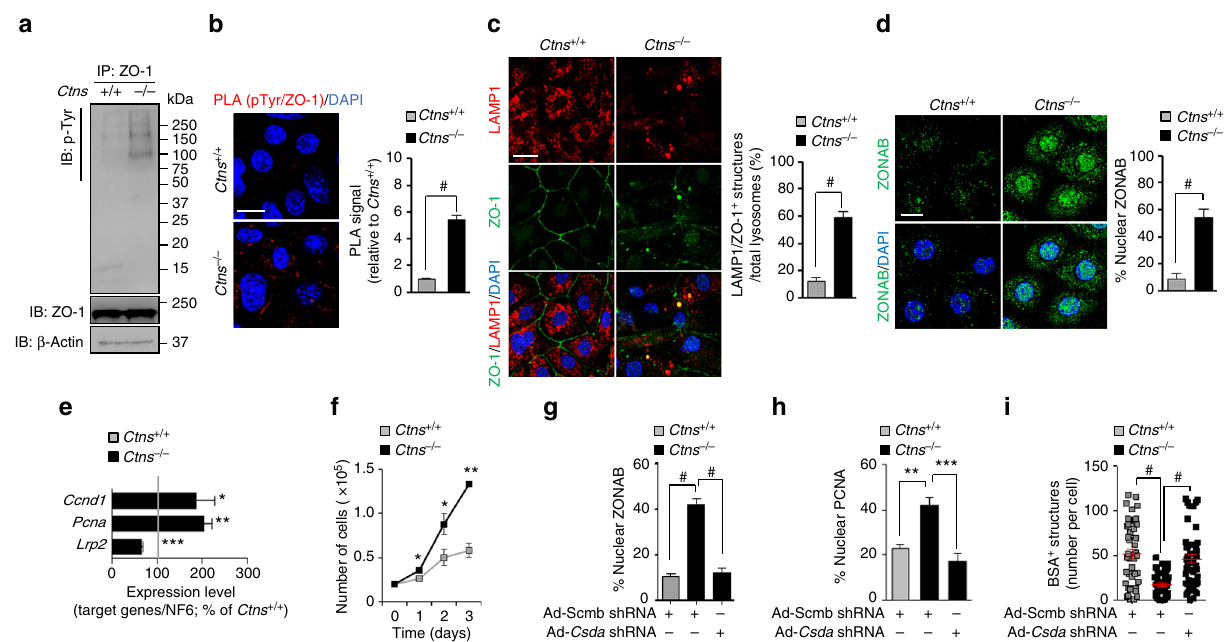
Fig. 7 Augmented phosphorylation rate of ZO-1 promotes epithelial dysfunction in Ctns − / − cells. a Tight junction ZO-1 protein was immunoprecipitated from Ctns + / + and Ctns − / − mPTCs, and its phosphorylation rate was examined by western blotting, n = 2 independent experiments. b Confocal analysis of endogenous phosphorylation of ZO-1 by proximity ligation assay (PLA), and c of ZO-1/LAMP1 + structures (in percentage of the total lysosomes) and d of ZONAB + nuclei (in percentage of the total nuclei) in Ctns mPTCs. Quanti fi cations in b , c , and d were obtained from fi ve randomly selected fi elds per condition, with each containing ~ 20 – 25 cells; two-tailed unpaired Student ’ s t -test, # P < 0.0001 relative to Ctns + / + mPTCs. e The mRNA levels of Lrp2, Ccdn1 , and Pcna in Ctns microdissected proximal tubules were analysed by real-time PCR, n = 3 mice per group. Two-tailed unpaired Student ’ s t -test, * P < 0.05, ** P < 0.01, and *** P < 0.001 relative to Ctns + / + microdissected proximal tubules. f Growth curves of Ctns mPTCs. Two-tailed unpaired Student ’ s t - test, * P < 0.05 and ** P < 0.01 relative to Ctns + / + mPTCs, n = 3 independent experiments. g – i Ctns mPTCs were transduced with Scmb or Csda adenoviral shRNAs for 5 days. g Confocal analysis and quanti fi cation of ZONAB + nuclei and h of PCNA + nuclei in Ctns mPTCs. The quanti fi cations (expressed in percentage of the total nuclei) were obtained in g and h from four randomly selected fi elds per condition, with each containing ~ 20 – 25 cells. i The cells were loaded with Al647-BSA (50 μ g ml − 1 for 15 min at 37 °C) and imaged by confocal microscopy. Quanti fi cation of numbers of Al647-BSA + structures ( n = 45 – 50 cells pooled from three mouse kidneys per condition; each point representing the number of BSA + structures in a cell). One-way ANOVA followed by Bonferroni ’ s post hoc test, ** P < 0.01, *** P < 0.001, and # P < 0.0001 relative to Ctns + / + mPTCs transduced with Ad-Scmb shRNA or to Ctns − / −